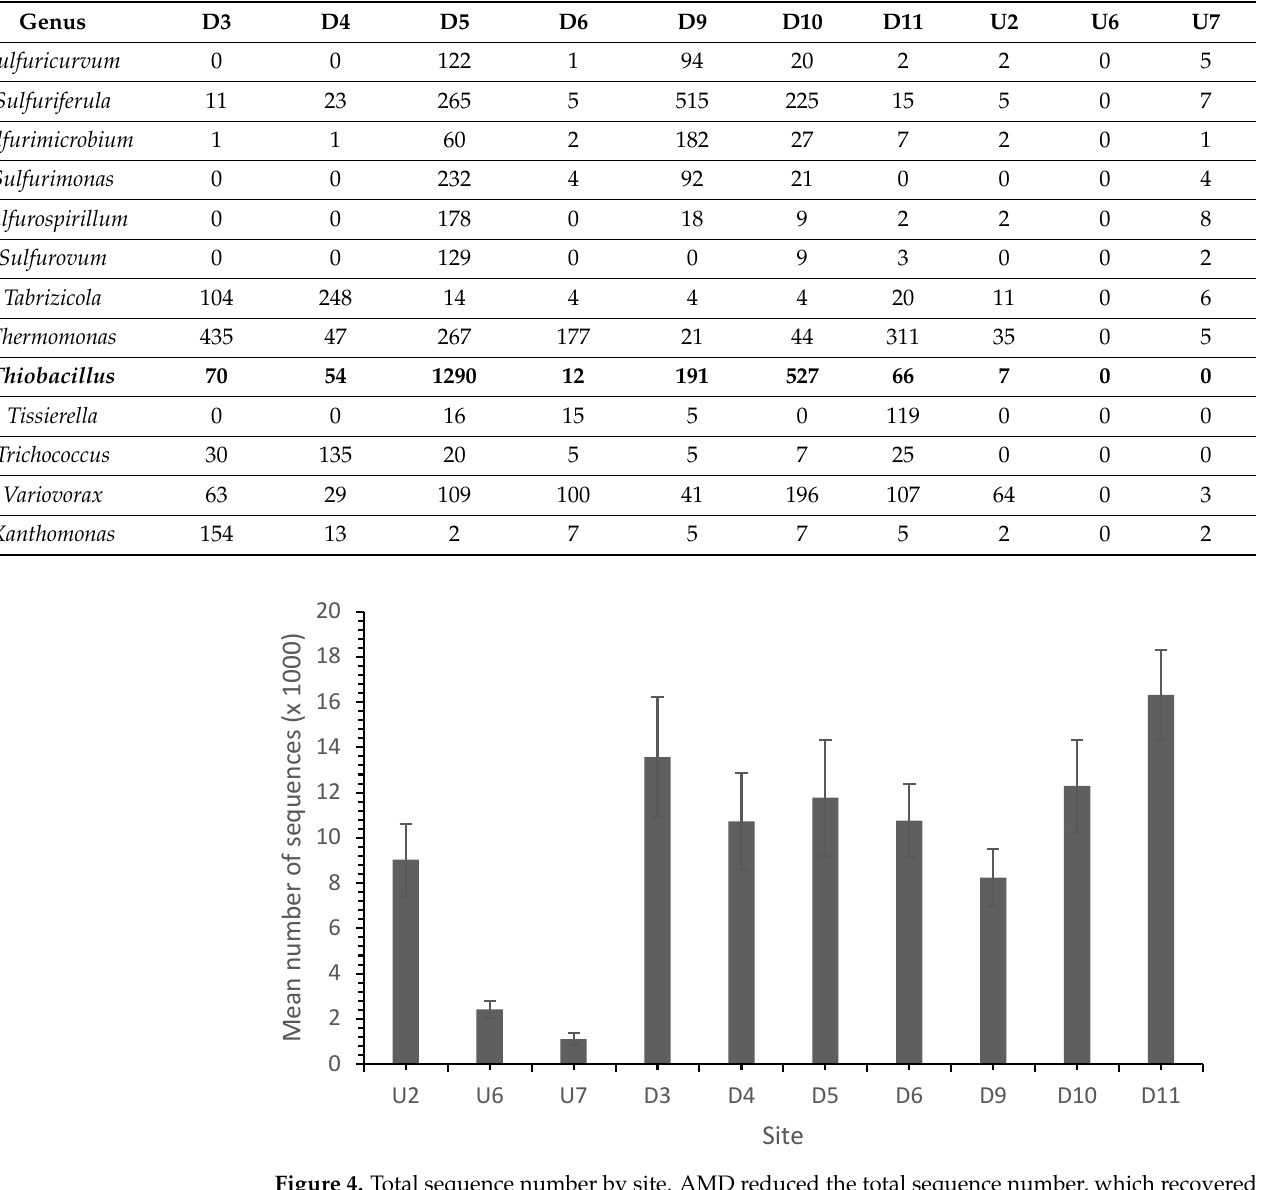
Table 6. XRF values by element in ppm and location (rounded to the nearest whole number). Values highlighted in bold were the downstream values that appeared to be notably higher than the values from the upstream group. Values highlighted in italics were the downstream values that appeared to be notably lower than the values from the upstream group. Values in parentheses indicate results that did not appear to fit the trend and were treated as spikes.